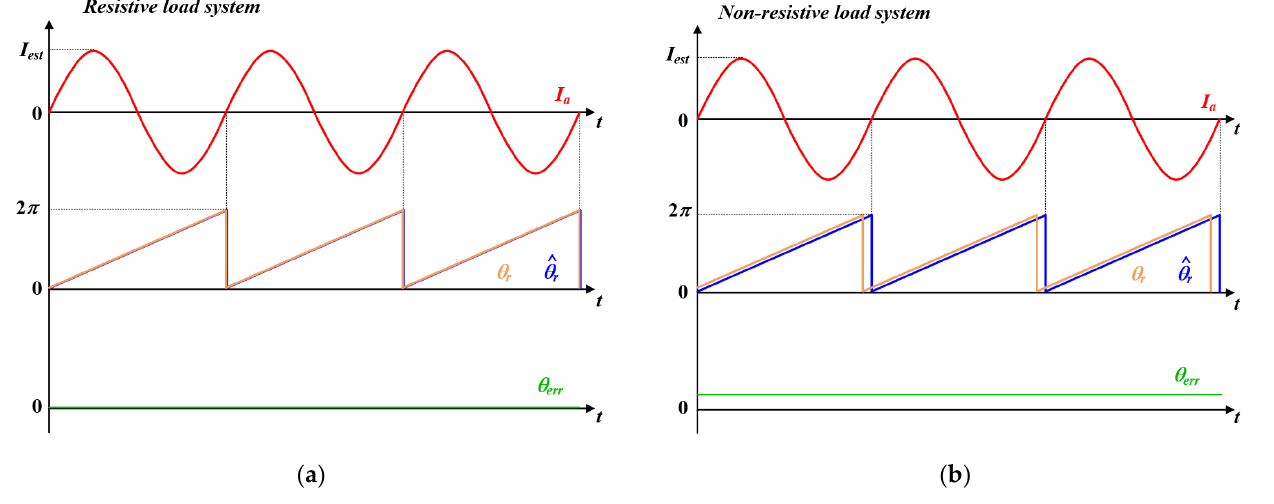
Figure 3. The a -phase stator current, actual rotor position, and estimated rotor position waveforms according to the load condition. ( a ) A resistive load system and ( b ) a non-resistive load system.